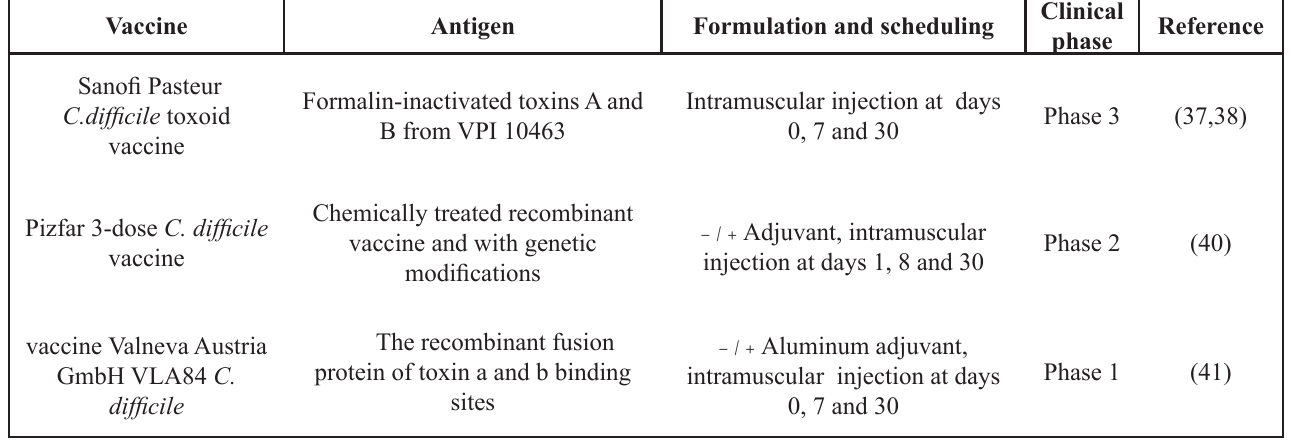
Table 2. Vaccines under development against